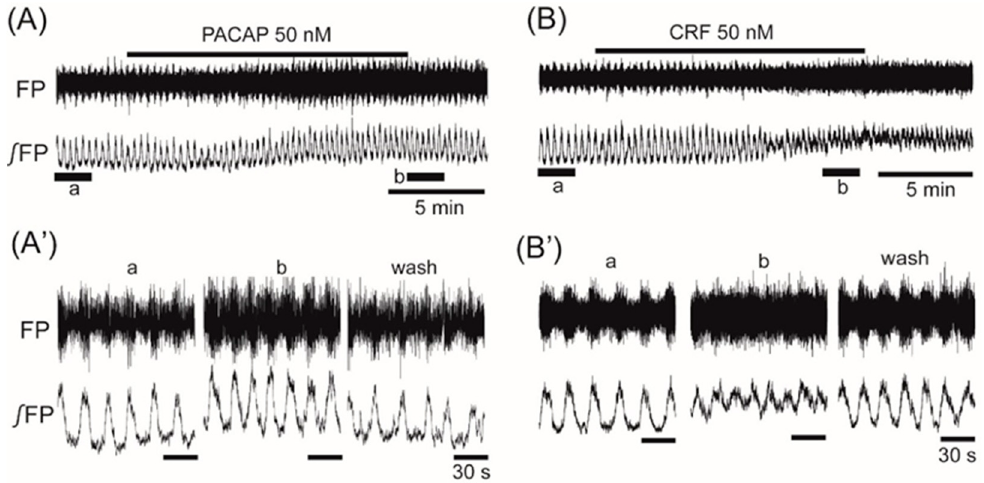
Figure 2. The effects of anorexigenic neuropeptides PACAP (pituitary adenylate cyclase-activating polypeptide) and corticotropin-releasing factor (CRF) on oscillation in the ventromedial hypothalamus. ( A , B ) Examples of continuous recordings of ventromedial hypothalamus field potential before and after the application of 50 nM PACAP and 50 nM CRF, respectively. potential; wash: